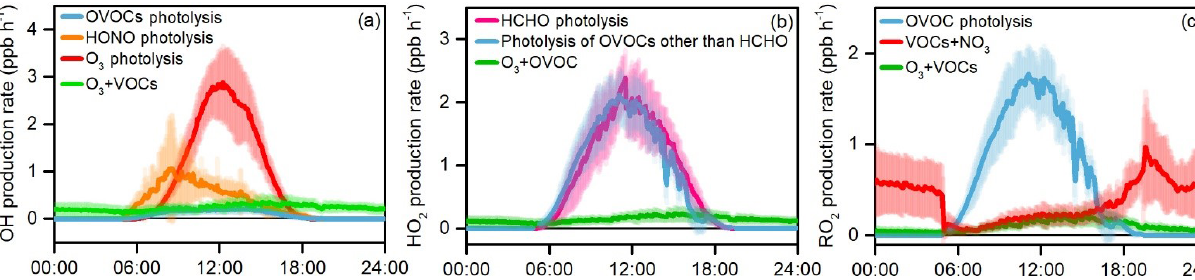
Figure 11. Simulated average primary production rates of (a) OH, (b) HO 2 , and (c) RO 2 during the summertime O 3 pollution episodes. The error bars indicate the standard deviations of the mean.